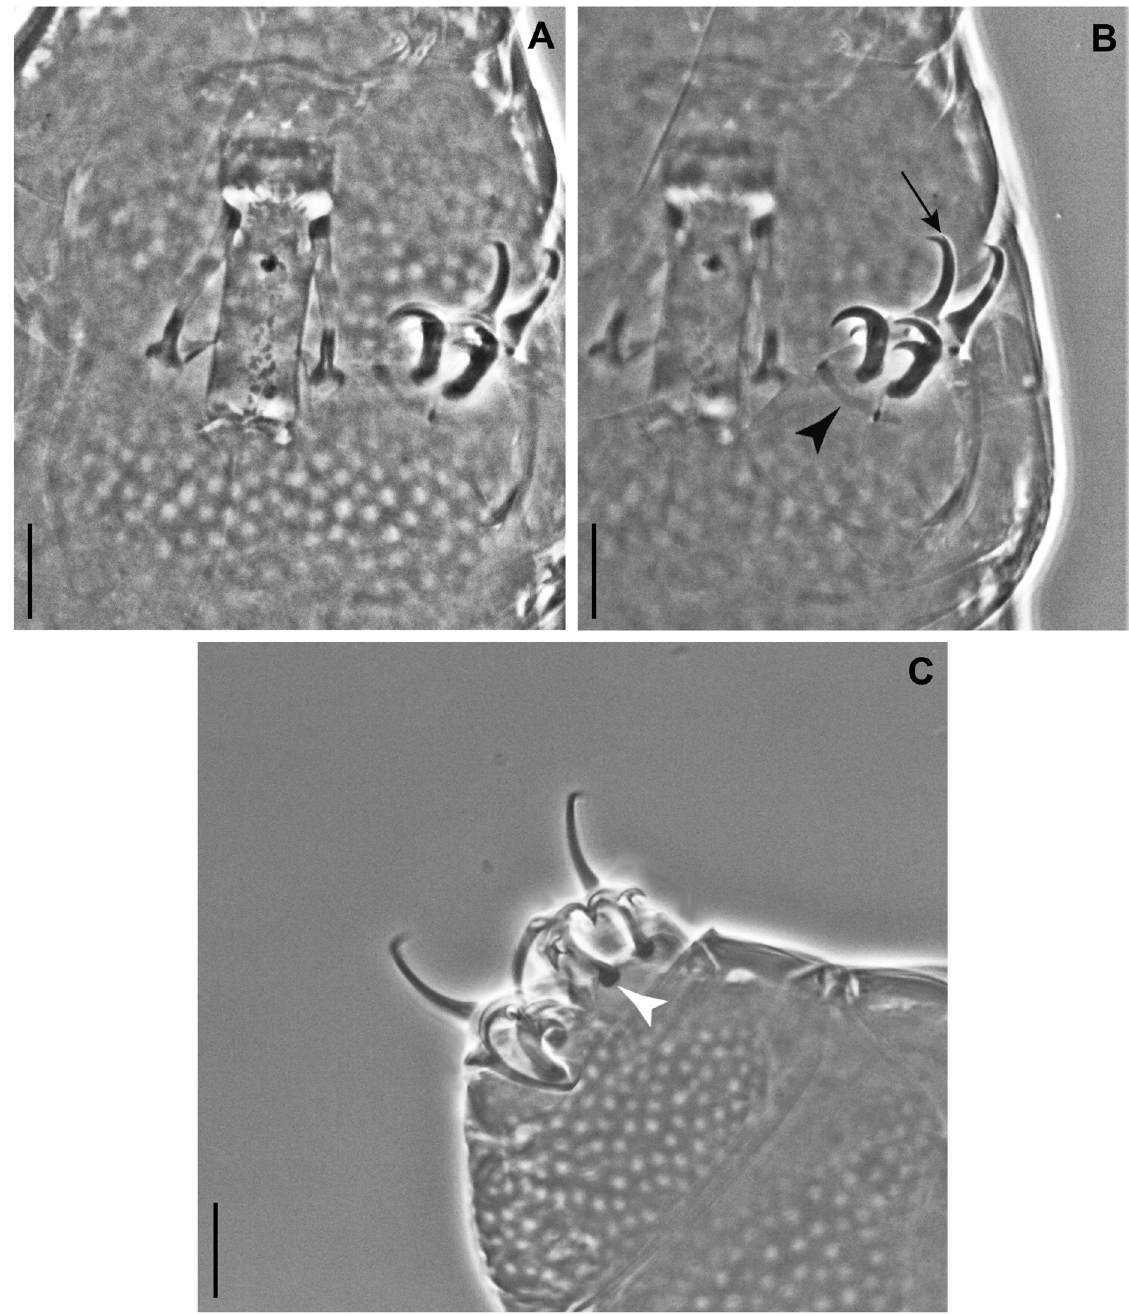
Fig. 7. Milnesium pelufforum sp. nov., paratype, young (slide No. UNLPam 503-1). Buccal tube and claws. A . Buccal tube and related structures. B . Claws of legs I; the black arrow indicates the accessory points, the black arrowhead indicates the leg cuticular bar. C . Claws of legs IV; the white arrowhead indicates a ‘lunule’. Scale bars = 10